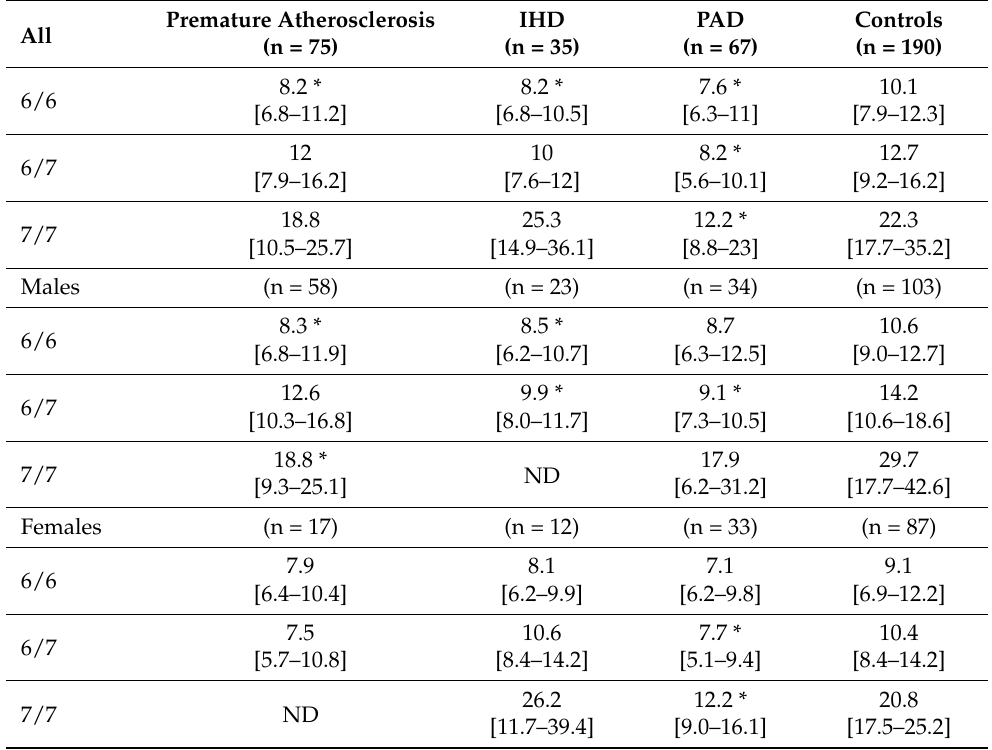
Table 2. Serum bilirubin concentrations in patients with atherosclerosis according to the UGT1A1 genotype.